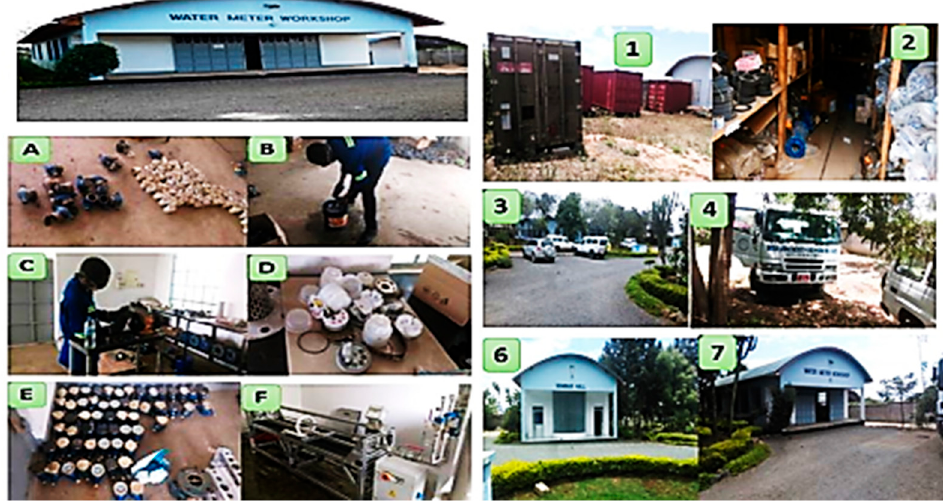
Figure 3. Part of O&M infrastructure in Hai & Siha (Source: Field work data).